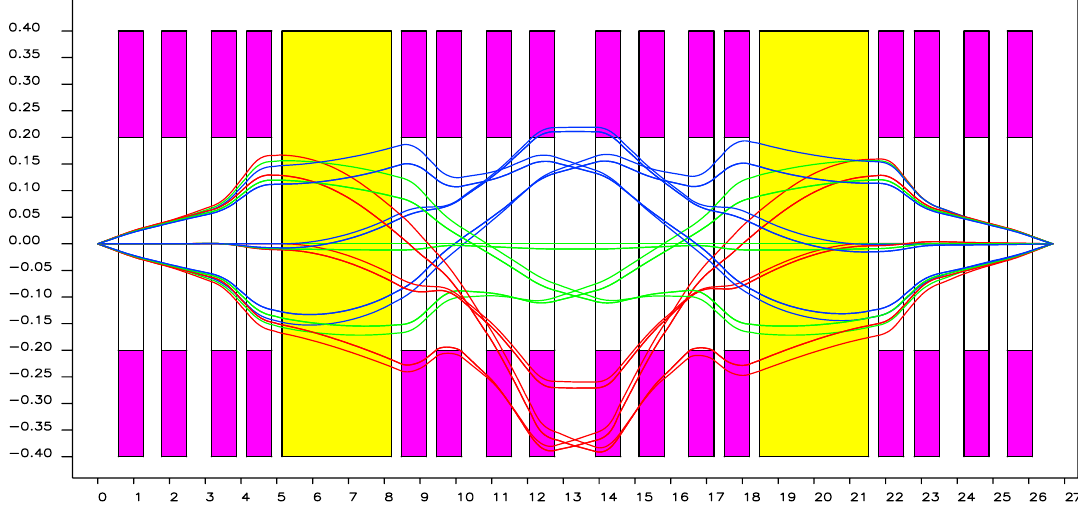
FIG. 3. (Color) Third order horizontal envelope corresponding to acceptance (initial beam emittance of (cid:10) 1 mm , (cid:10) 40 mrad horizontally and (cid:10) 50 mrad vertically, and (cid:10) 10% energy dispersion).